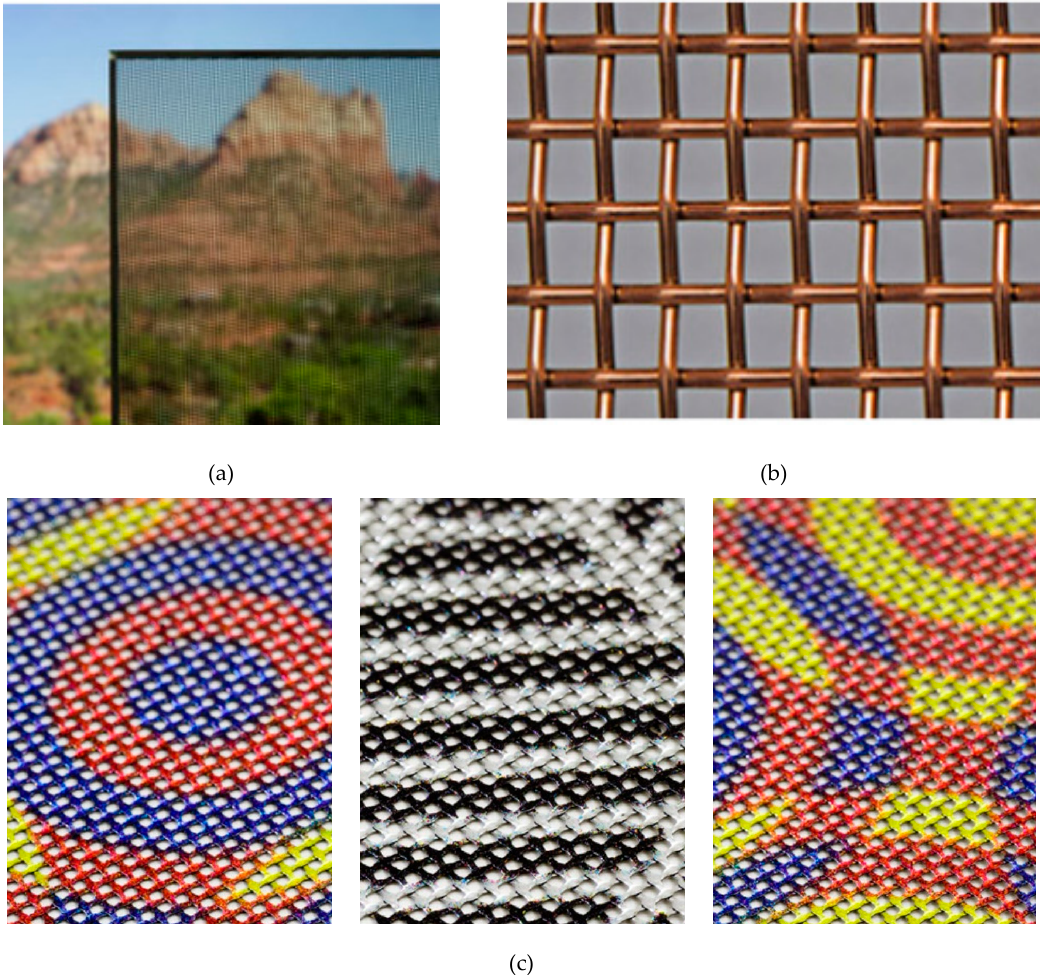
Figure 10. Examples of textile glass: ( a ) front view with ( b ) mesh detail, or ( c ) selection of possible coloured mesh fabrics (reproduced from [71]).